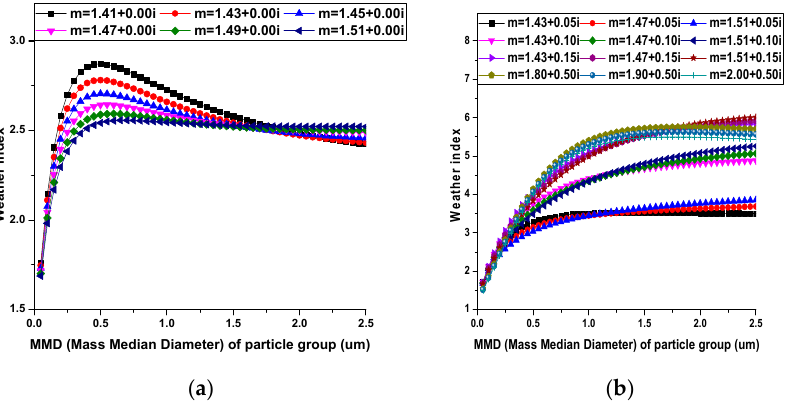
Figure 6. Relationship between MMD (Mass Median Diameter) of particle groups and the weather index: ( a ) non-absorbing particles; ( b ) absorbing particles.